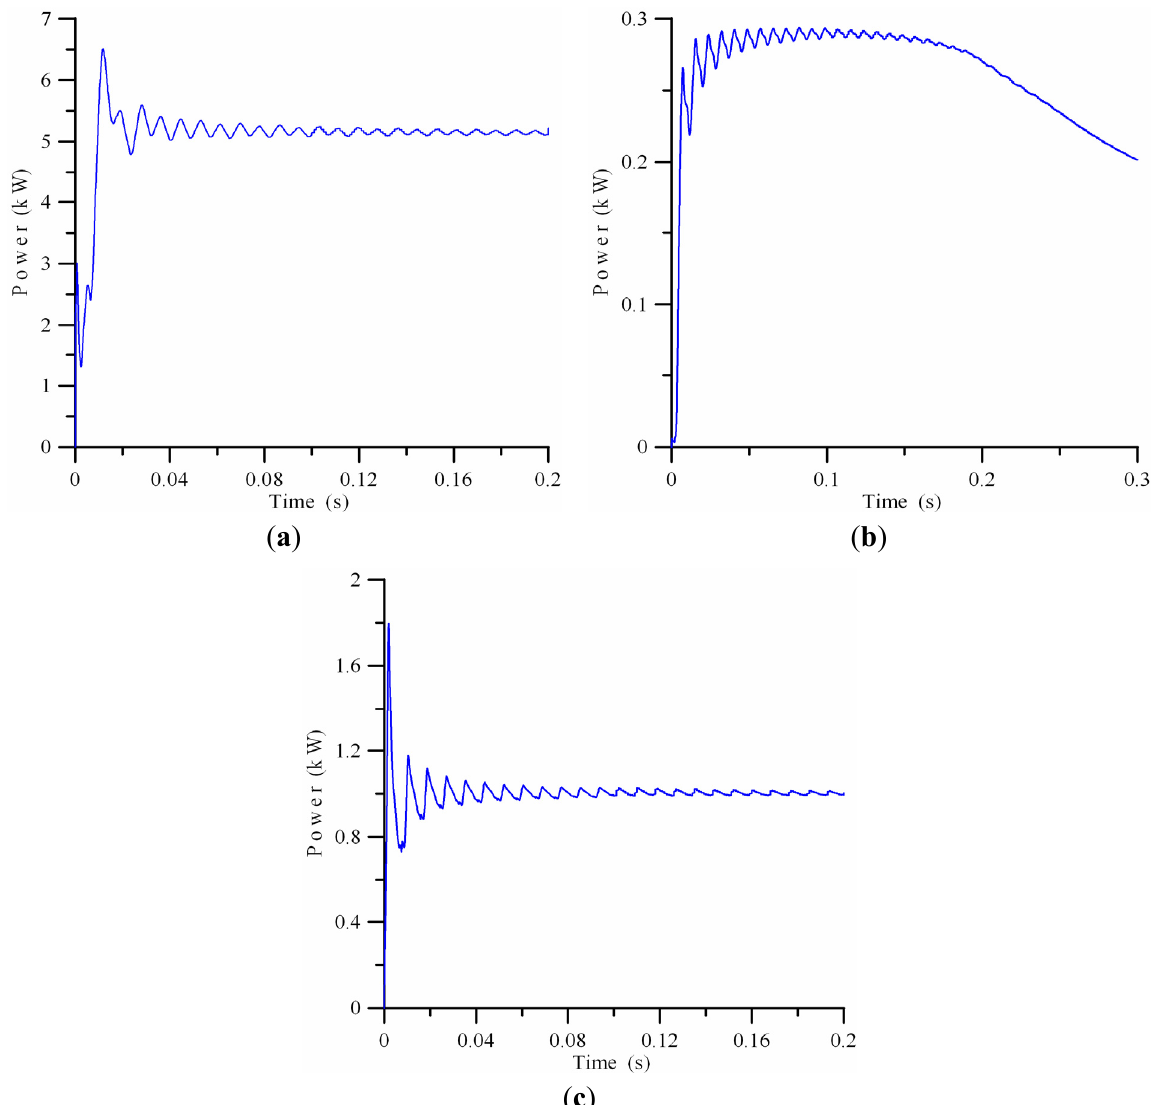
Figure 9. Experiment of load turn-on instantaneous transient power for case 3. ( a ) a three-phase R-L linear load; ( b ) a one-phase 0.2 hp induction motor; ( c ) a three-phase 1 hp induction